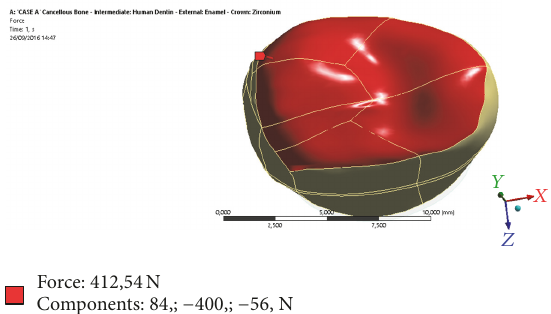
Figure 1: The mesh model of the dental prosthodontic crown. Shape of each material and layer.